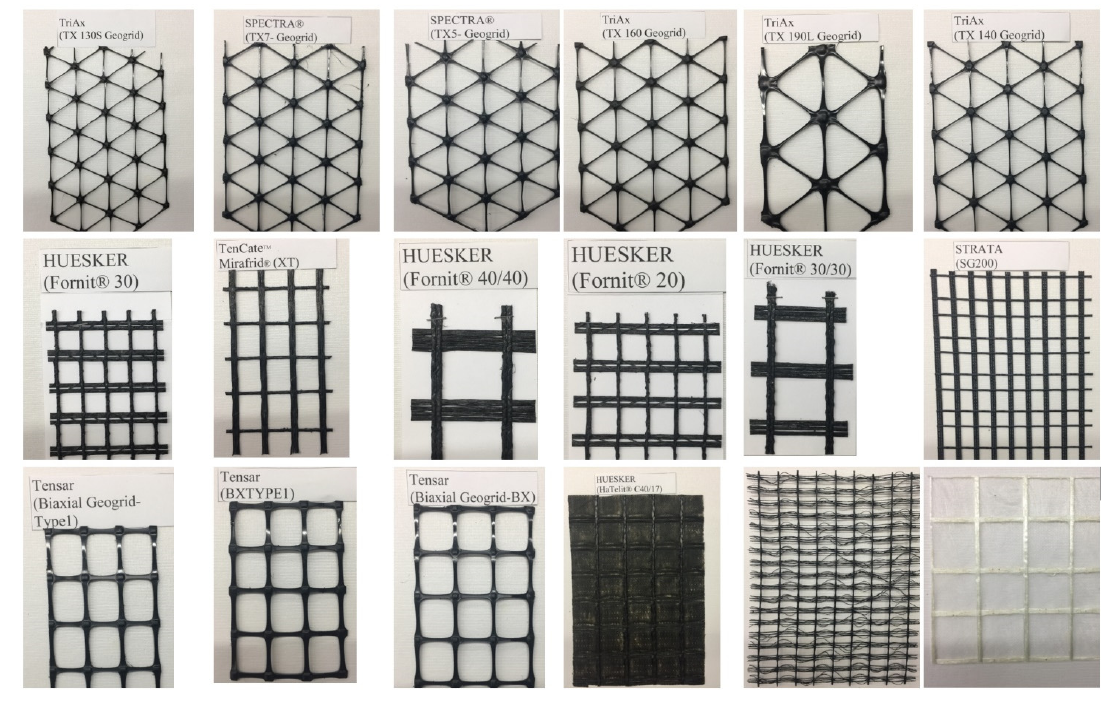
Figure 1. Variety of geogrid materials being produced. Table 2. Typical properties from a leading manufacturer of geogrids 1 showing the variation of properties across different material classes.